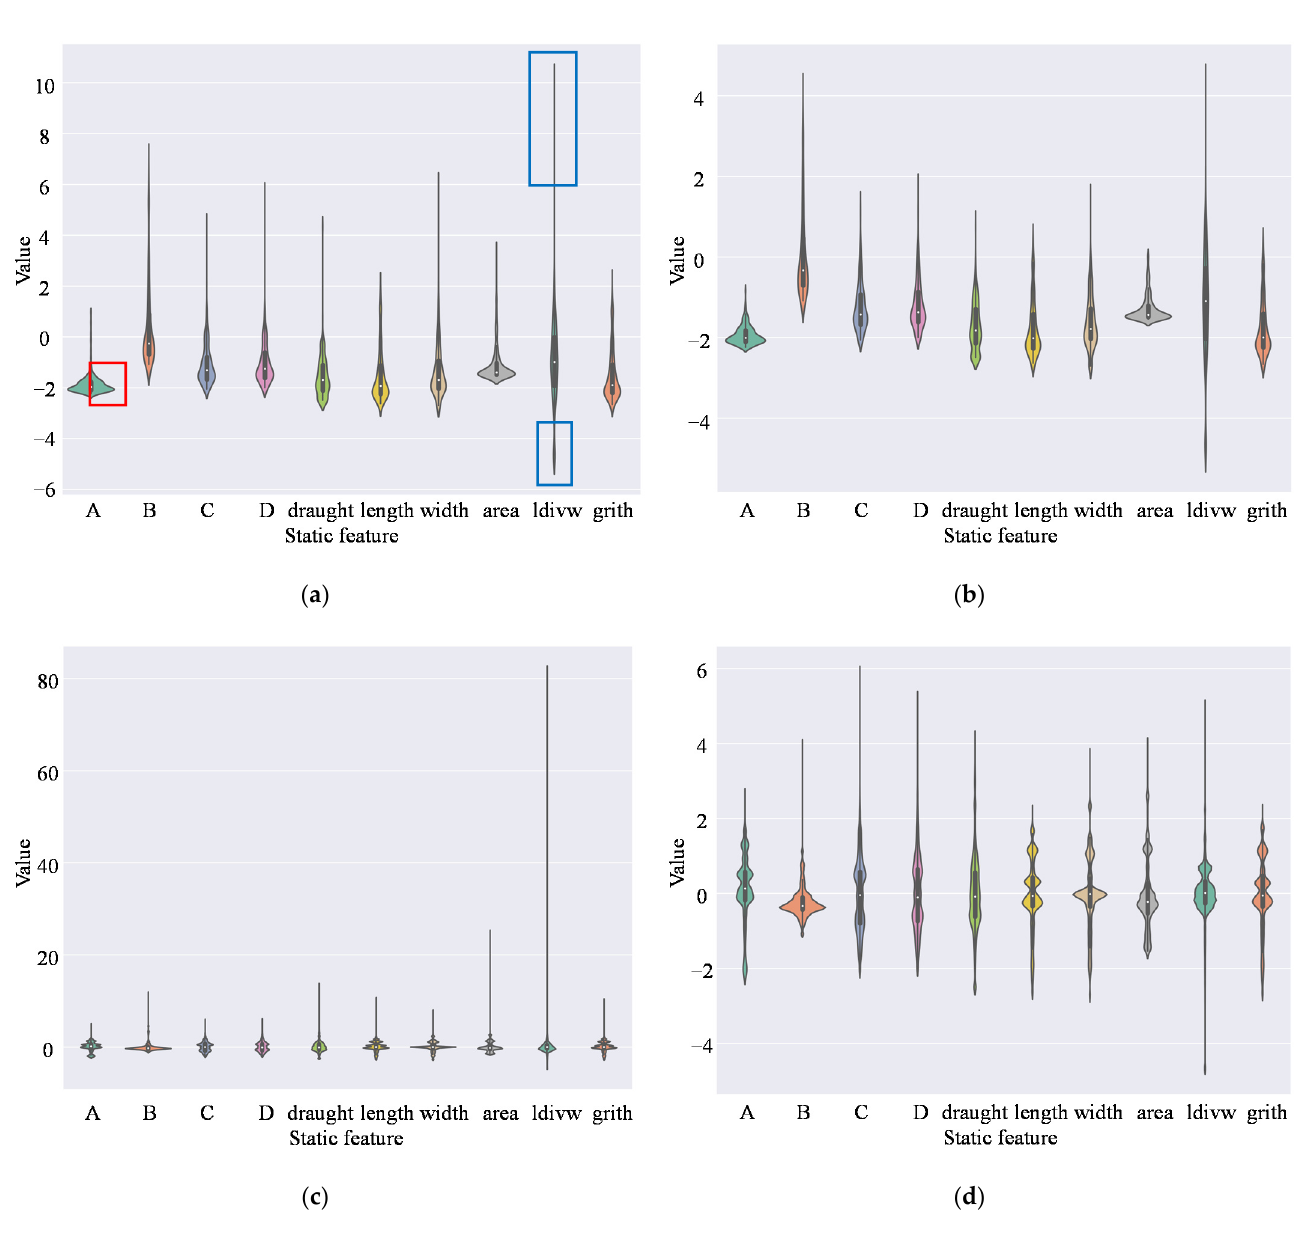
Figure 6. Distribution of original static data and the data after removing outliers. ( a ) Violin plot of passenger ships’ static features; ( b ) Violin plot of passenger ships’ static features (after removing outliers); ( c ) Violin plot of four types of ships’ static features; ( d ) Violin plot of four types of ships’ static feature (after removing outliers).